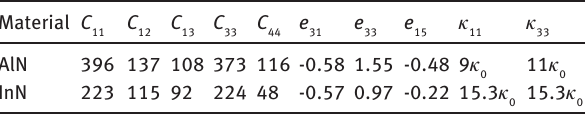
Table 1 Elastic constants (in GPa), piezoelectric constants (in C/m 2 ), and dielectric constants (in F/m) for AlN and